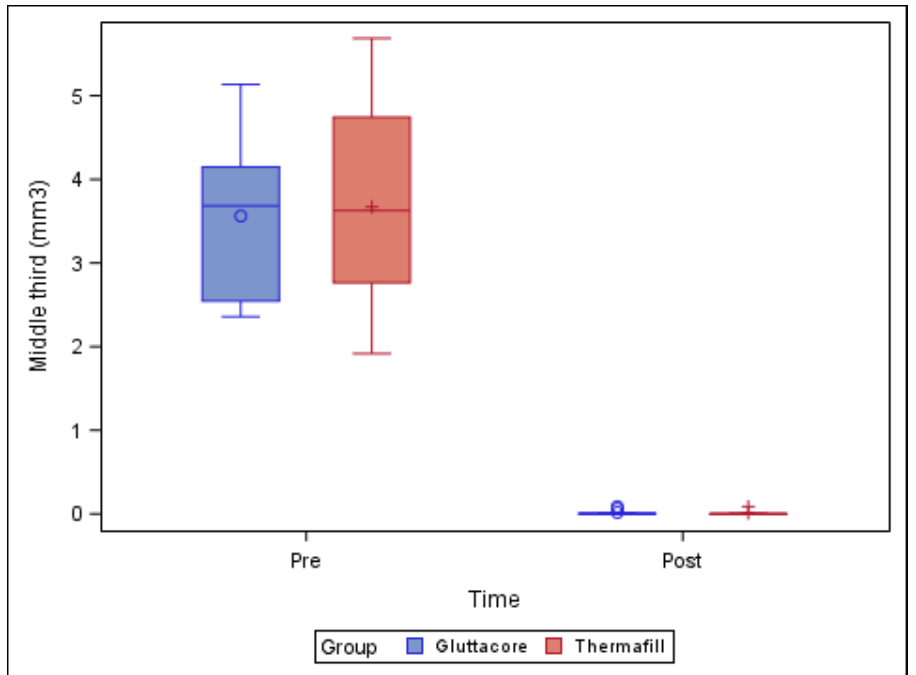
Figure 3. Box plot of the pre-operative root canal filling material volume (mm 3 ) and the remaining post-operative root canal filling material volume (mm 3 ) at the middle third of the straight root canal systems, categorized by root canal filling material system.